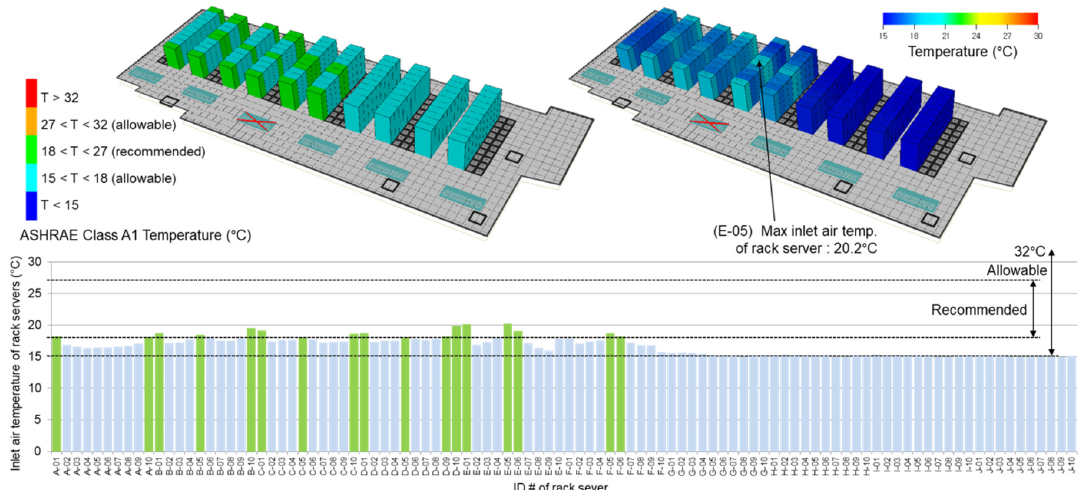
Figure 14. ALT-3 HAC with raised floor — the mean inlet air temperature of 100 server racks in cooling fault condition.